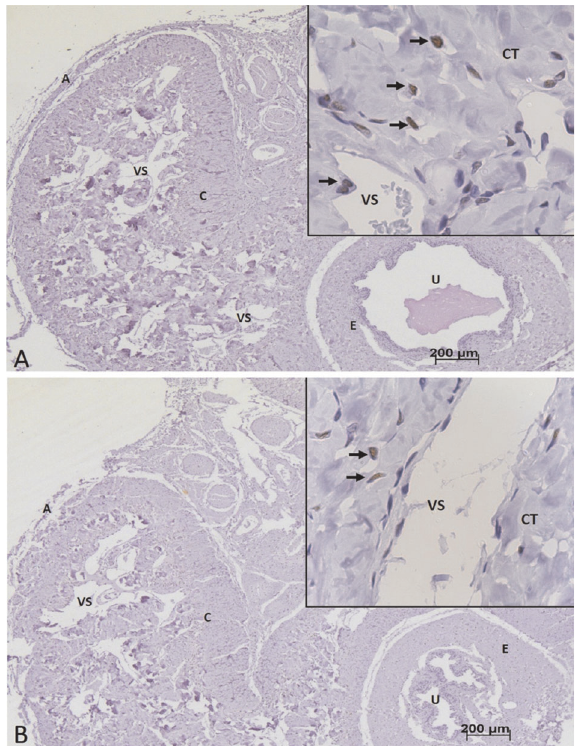
Figure 2. Representative immunohistochemical photomicro- graphs of adrenomedullin (AM) and calcitonin receptor-like receptor (CRLR) in rat cavernosal smooth muscle sections. AM ( A ) and CRLR ( B ) nuclear staining (arrows on the images in detail) were detected diffusely in all constituents of the cavernous tissue (CT): connective tissue, endothelium lining the vascular spaces and in smooth muscle. A: tunica albuginea; C: corpora cavernosa; E: spongy body; VS: vascular spaces; U: urethra. Magnification 50 6 and 1000 6 (inset).